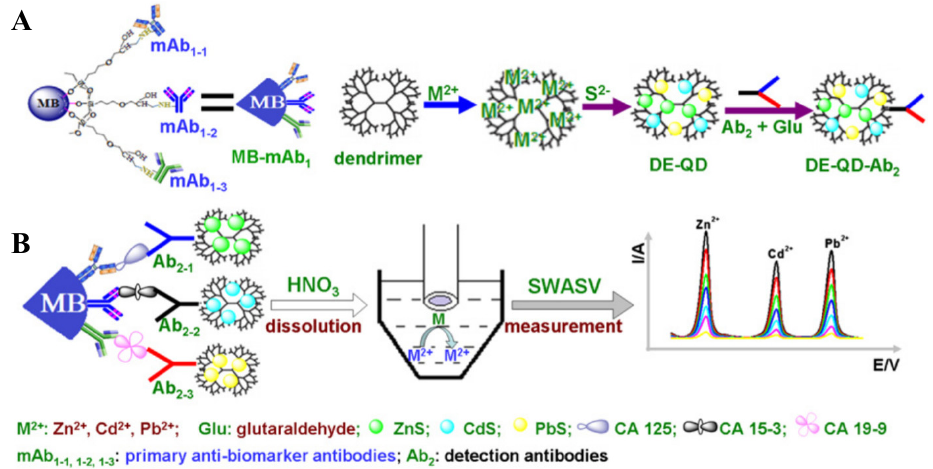
Figure 33. ( A ) Use of signaling antibodies coupled to dendrimers (PAMAN) containing metal sulfides, and ( B ) subsequent electroreduction by ASV for detection. This method allows detecting several antibody ‐ antigen complexes. Reprinted from [169], Copyright 2013, with permission from Elsevier.